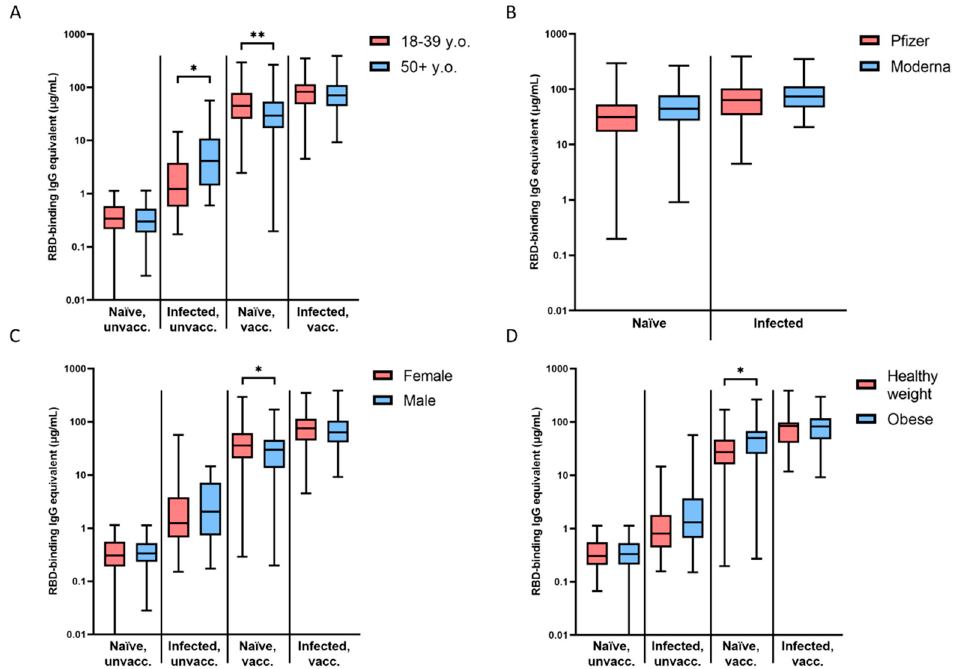
Figure 2. Magnitude of initial seroconversion based on demographic information. ( A ) Differences between young (18–39 y.o.) and older (50+ y.o.) participants were significant in infected, unvaccinated (* p = 0.0334) and naïve, vaccinated (** p = 0.0038) groups. ( B ) Differences between Pfizer and Moderna vaccinees were not significant. ( C ) Differences between females and males were significant in the naïve, vaccinated (* p = 0.0438) group. ( D ) Differences between participants with a healthy weight (BMI = 18.5–24.9) and those who were obese (BMI ≥ 30) were significant in the naïve, vaccinated group (* p = 0.0119). Initial seroconversion is designated by timepoints 0.5–1 month after COVID-19 infection or the reception of the primary vaccine series (2 × mRNA or 1 × viral vector).